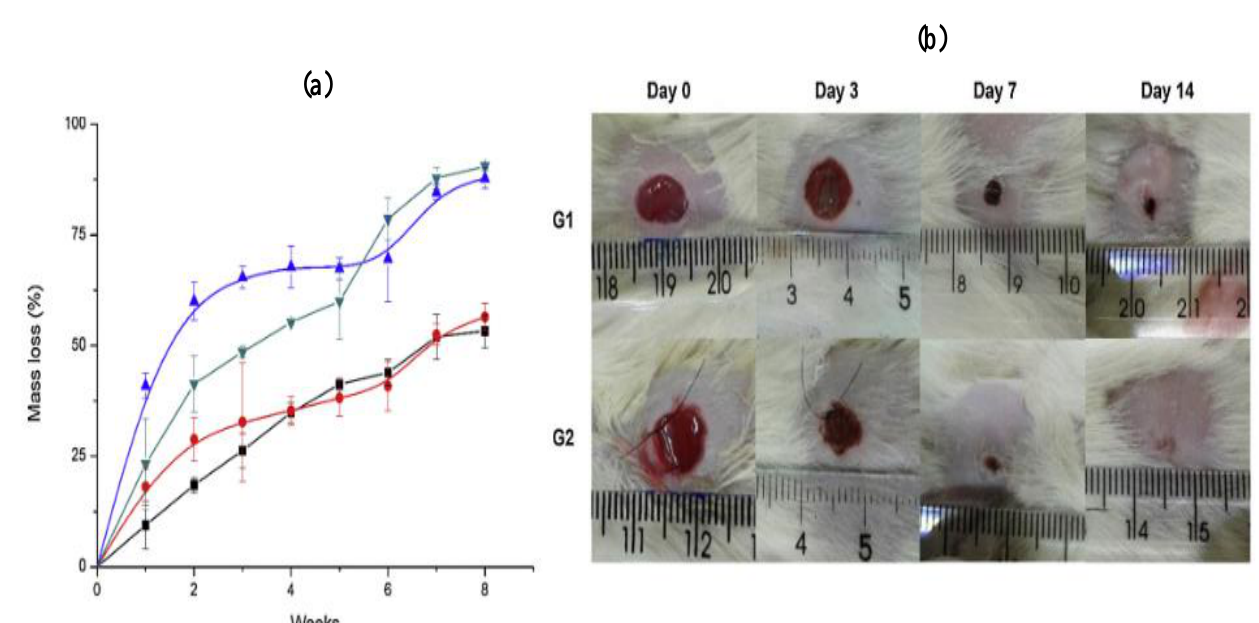
Figure 11. ( a ) pure chitosan film (CHS) and HPUC mass loss curves after up to eight weeks: ◼ CHS, ● HPUC1, ▼ HPUC2 and ▲ HPUC3. All values are expressed as mean ± standard deviation (n = 3). ( b ) Representative image in the effects of HPUC1 and mononuclear bone marrow fraction isolation (BMMNCs) on wound healing in diabetic ulcer model. (A) Macroscopic observations in wound areas in the control (G1) and wound healing contraction induced by HPUC1 plus BMMNCs (G2) (adapted with permission from [87]).